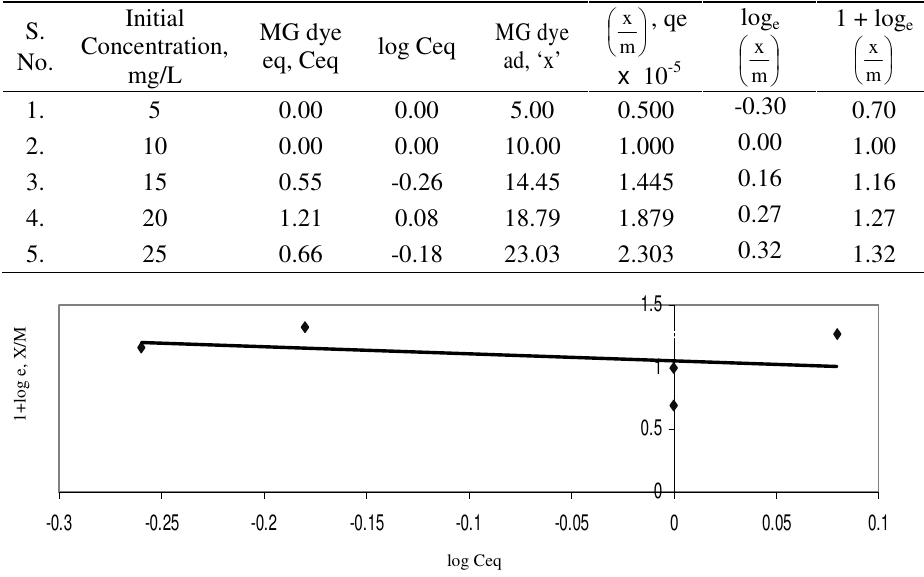
Figure 5. Data for Freundlich plot (150